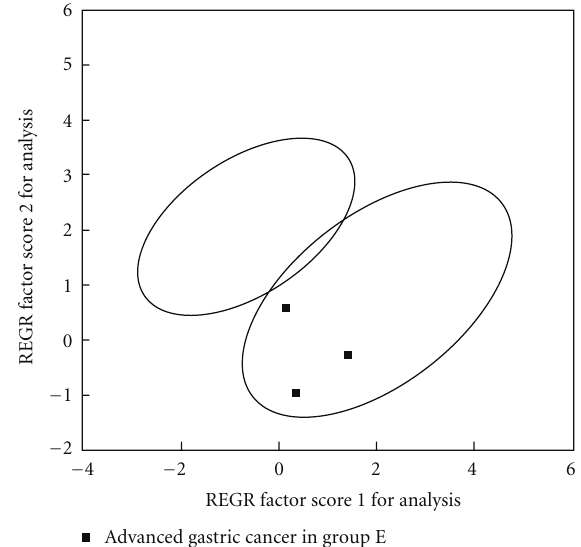
Figure 9: PCA of urine free amino acids of 3 advanced gastric cancer in group E (test result of diagnosis model for clinical